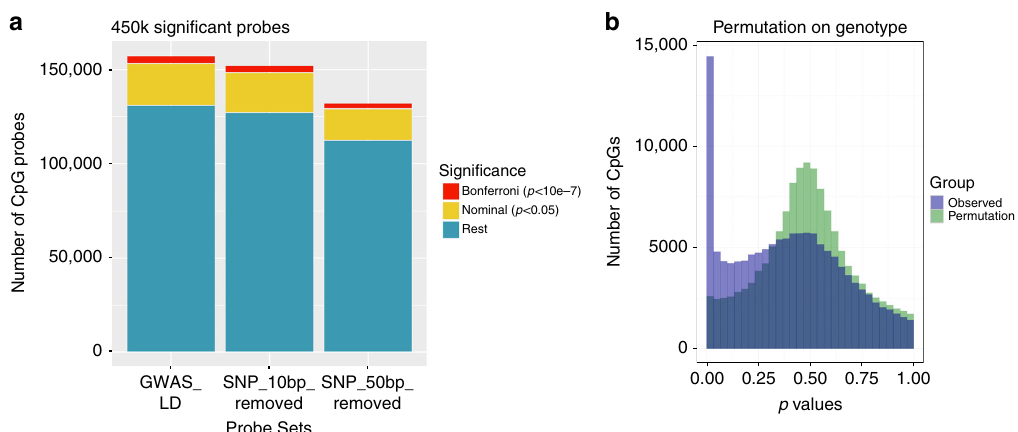
Fig. 10 Signi fi cant Illumina 450k probes. a Number of 450k CpG probes within the GWAS LD block regions that show signi fi cant results for genetic effects as captured by haplotype-tagging lead SNP. Separated into all probes within the entire region ( n = 157,473), and if probes pruned for those with SNPs within 10 bp (SNP_10bp_removed, n = 152,313) and 50 bp (SNP_50bp_removed, n = 132,221), respectively. Nominally signi fi cant results are shown in yellow and Bonferroni signi fi cant in red. b Observed p -values for CpG probes excluding those with common SNPs to 50 bp (in purple), versus results with the permutation of observed Genotype proportions (allelic count) (in green). This shows signi fi cant enrichment for low p -values in the observed data (empirical p <